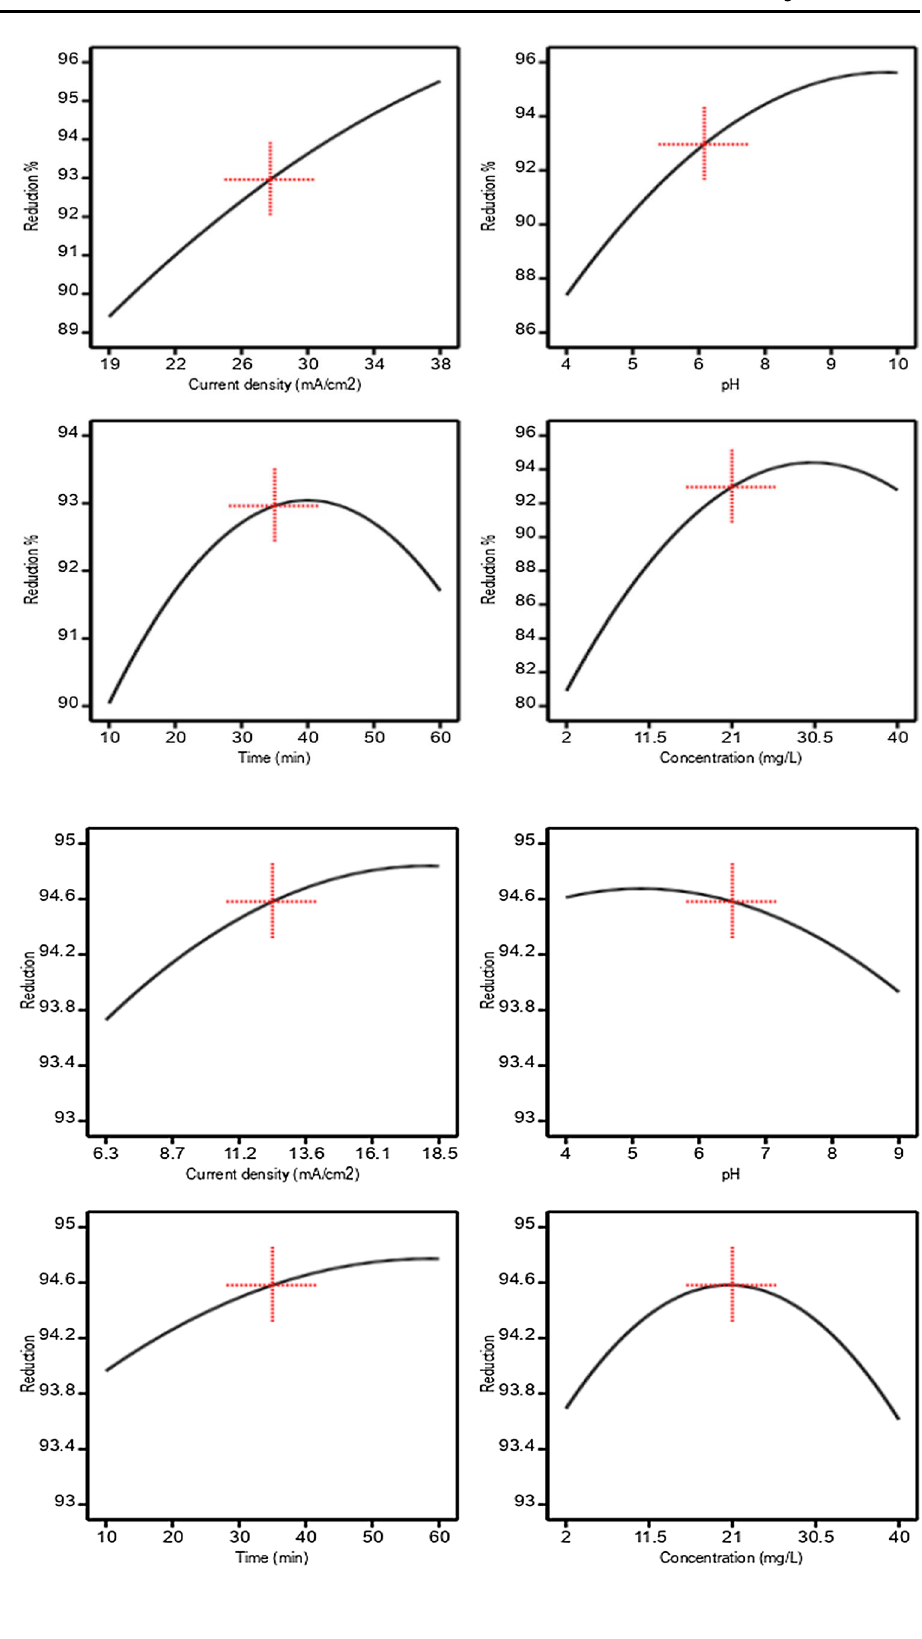
Fig. 5 Main effect plots of parameters for fluoride removal efficiency on Al-EC reactor